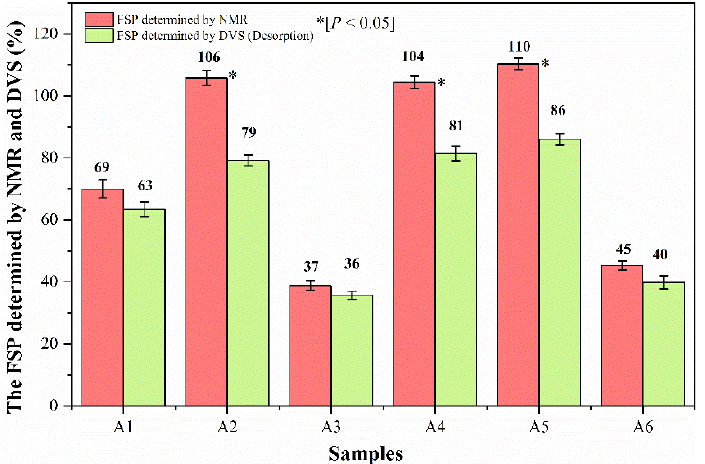
Figure 8. The fiber saturation point (FSP) determined by nuclear magnetic resonance (NMR) and dynamic sorption of water vapor (DVS). (A1–6, waterlogged archaeological wood). dynamic sorption of water vapor (DVS). (A1–6, waterlogged archaeological